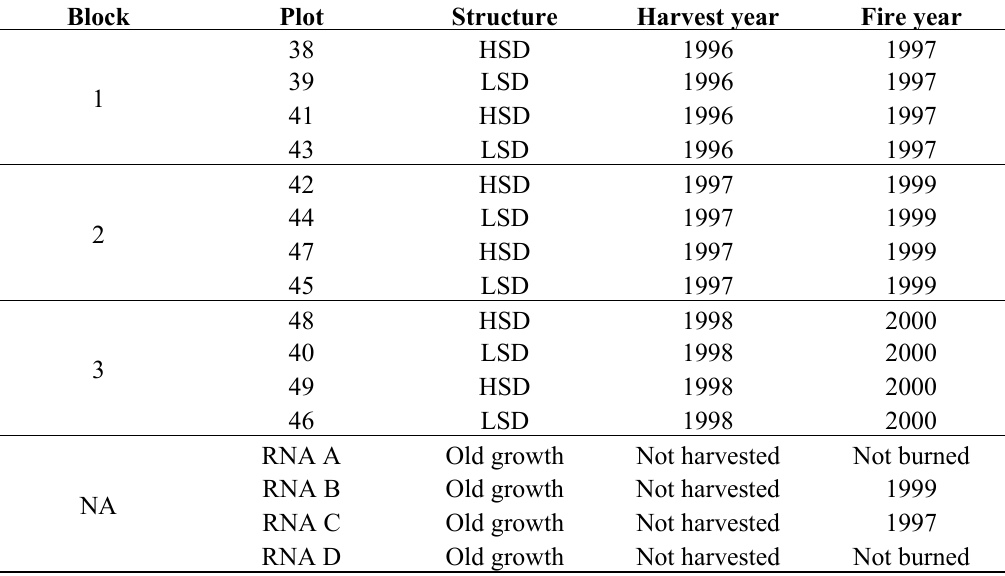
Table A. A summary of the complete treatment history for this interdisciplinary study at Blacks Mountain Experimental Forest. Treatment plots were numbered and RNAs were assigned letters. Plots whose samples provided the data included in this report are shaded. Block Plot Structure Harvest year Fire year 38 HSD 1996 1997 39 LSD 1996 1997 1 41 HSD 1996 1997 43 LSD 1996 1997 42 HSD 1997 1999 44 LSD 1997 1999 47 HSD 1997 1999 45 LSD 1997 1999 48 HSD 1998 2000 40 LSD 1998 2000 49 HSD 1998 2000 46 LSD 1998 2000 RNA A Old growth Not harvested Not burned RNA B Old growth Not harvested 1999 NA RNA C Old growth Not harvested 1997 RNA D Old growth Not harvested Not